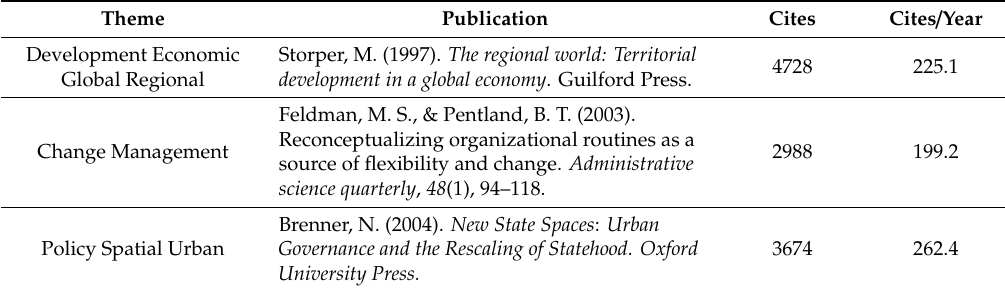
Table 5. Examples of highly cited